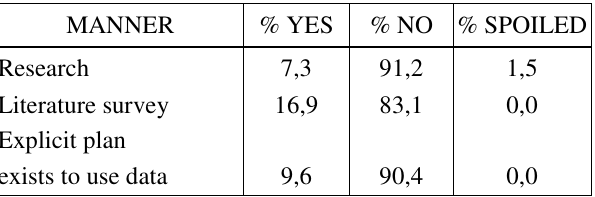
THE MANNER 0F SECURING AND USING ERGONOMIC